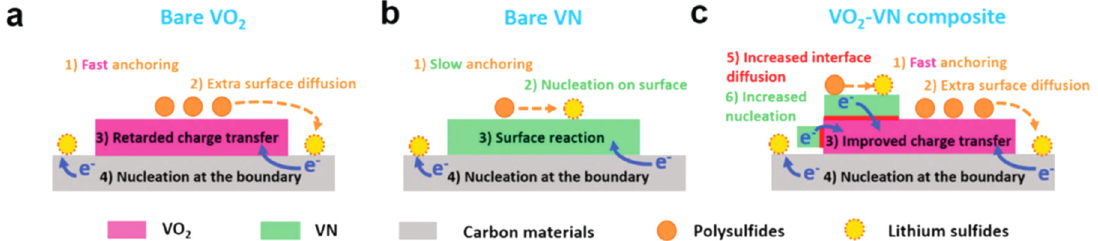
Figure 11. Illustration of LiPS anchoring-diffusion–conversion processes on VO 2 , VN, and VO 2 –VN binary host surfaces. Reproduced with permission from [85]. The Royal Society of Chemistry, 2018.